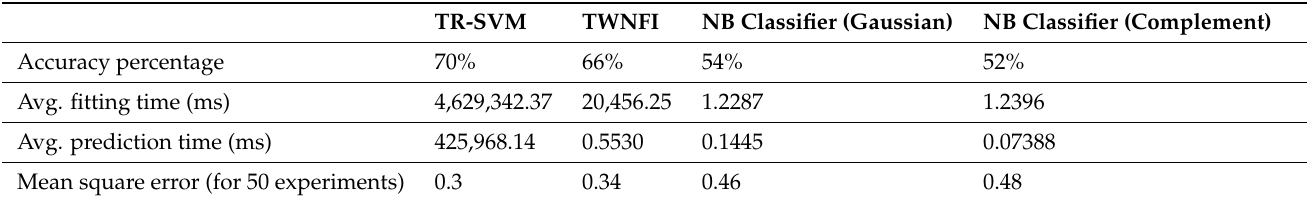
Table 2. Comparison of chosen machine learning algorithms for 500 samples.